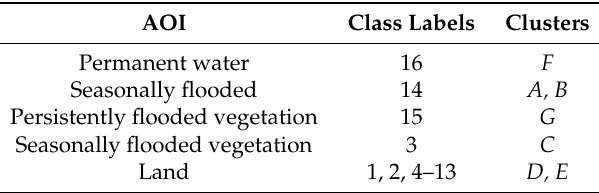
Table 3. Reclassification